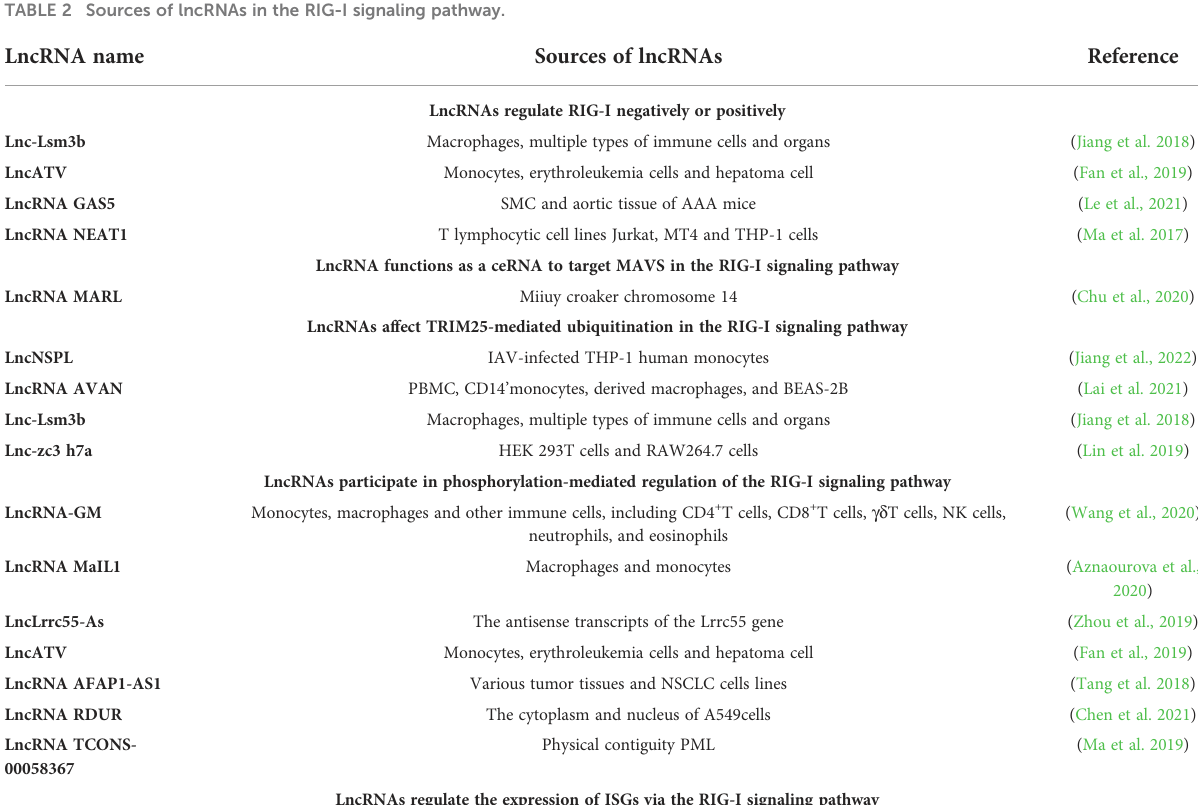
TABLE 2 Sources of lncRNAs in the RIG-I signaling